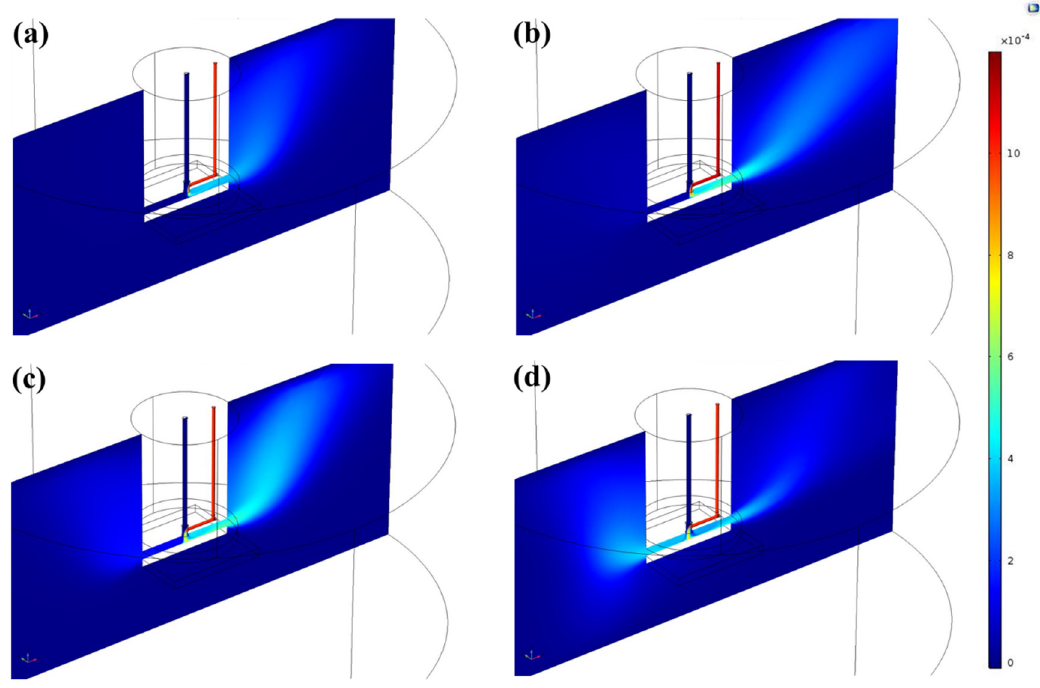
Figure 7. XZ-plane cross-sections of the monomer mass fraction distribution at 5 mm gap size for ( a ) 125 sccm, ( b ) 250 sccm, ( c ) 500 sccm, and ( d ) 750 sccm side gas flow rates.